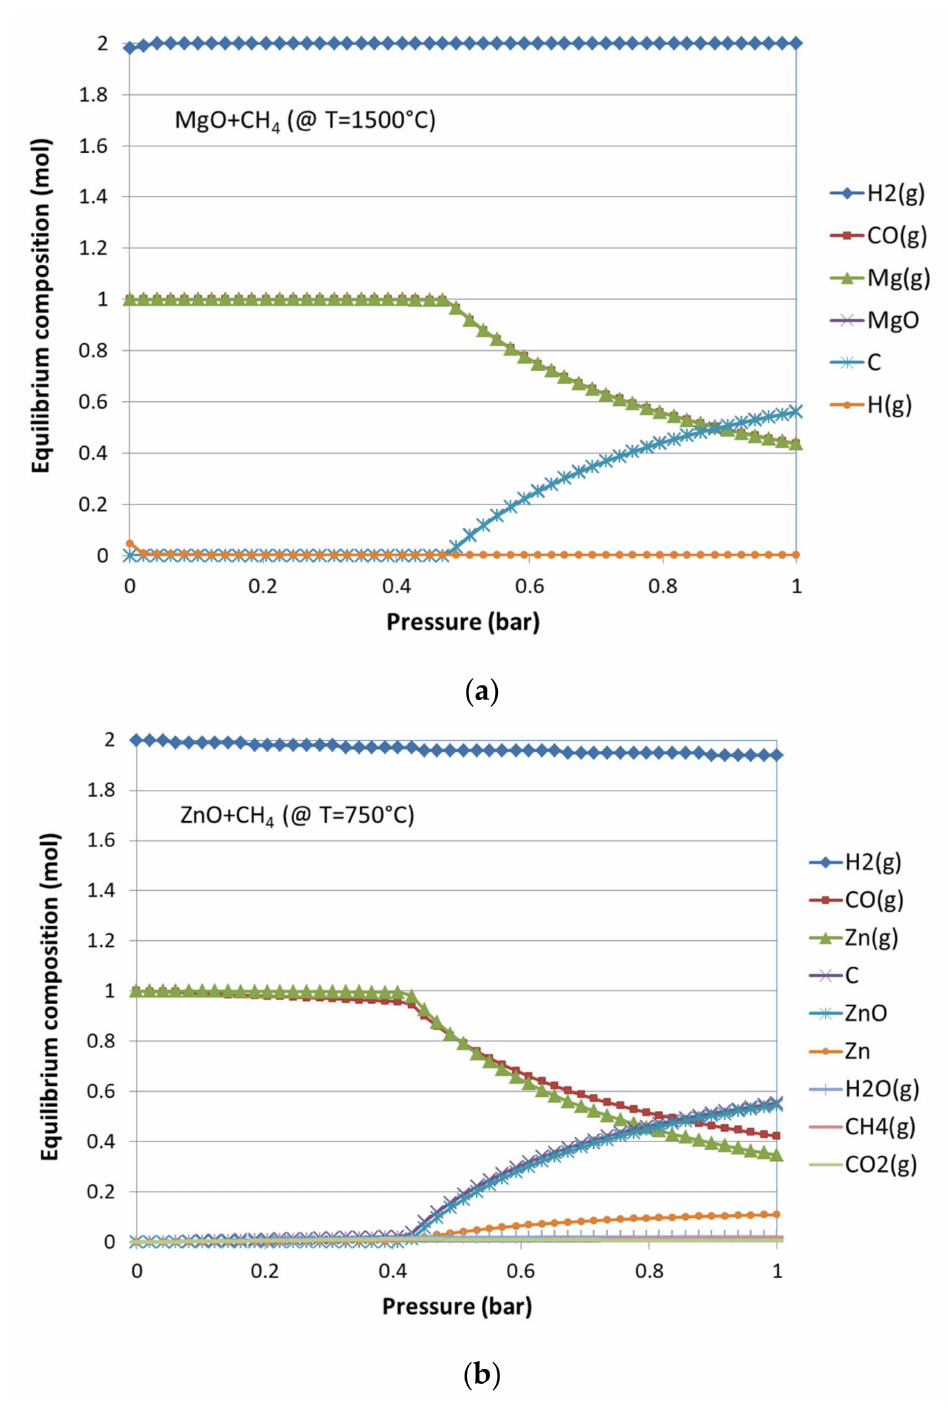
Figure 4. Influence of total pressure on equilibrium product distribution for the methano-thermal reduction of ( a ) MgO (at 1500 ◦ C) and ( b ) ZnO (at 750 ◦